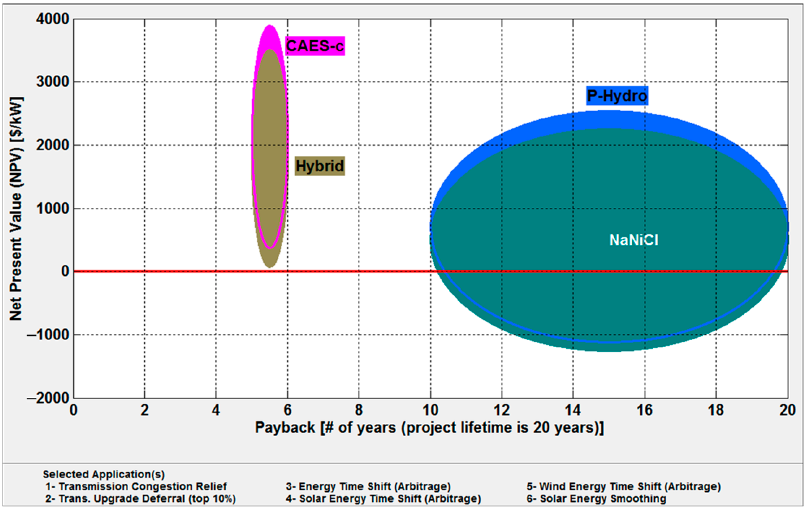
Figure 13. Net Present Value (USD/kW) as a payback function for each ESS.